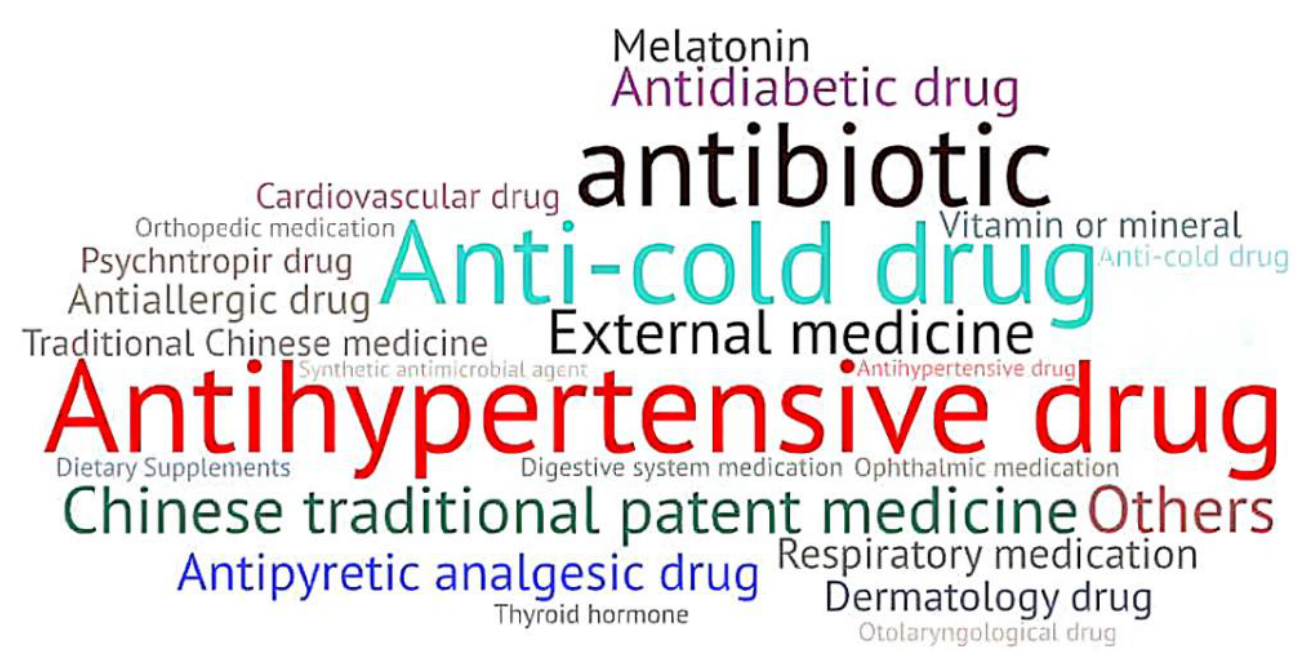
Figure 2. Word frequency map of “other” OTC medicines purchased and used by respondents.